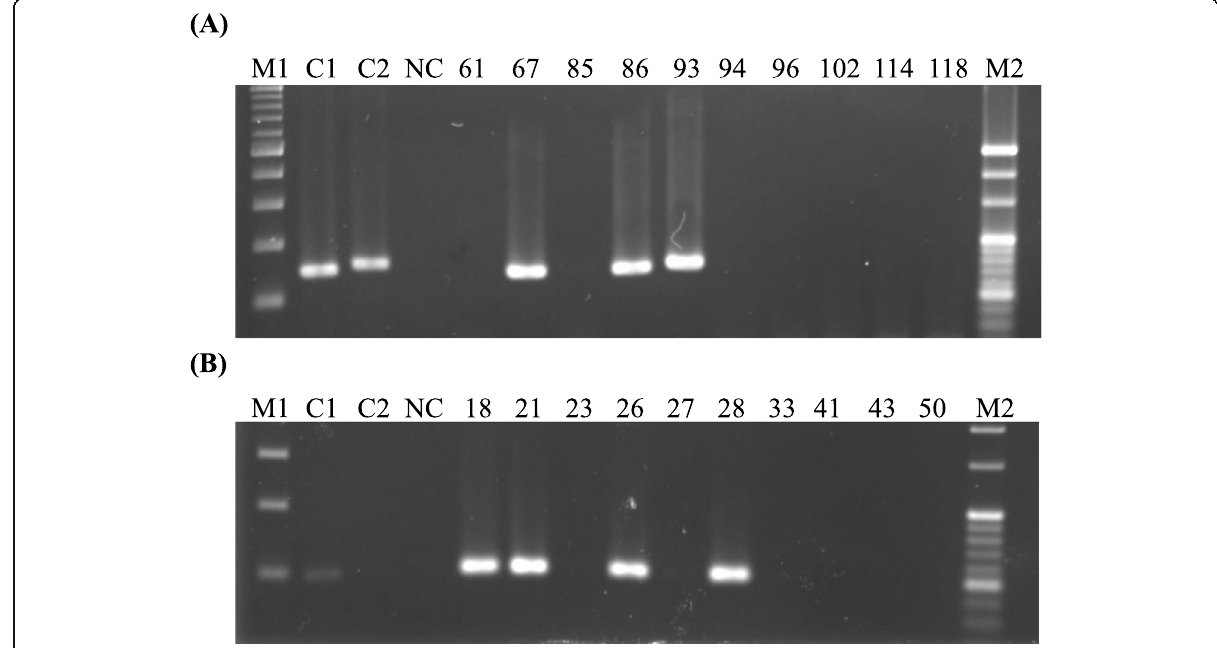
Fig. 3 An example of the electrophoresis of PCR products amplified from rice aDNA samples from the west trench at the Mojiaoshan site. a Amplicons obtained by using the specific primer targeting rps16 intron 1. b Amplicons obtained by using the specific primer targeting Orf100 F1 and R1. M1 = 100 bp DNA ladder (Takara, Japan), C1 = Oryza sativa Japonica ‘ Ta-pei-mang ’ , C2 = Oryza sativa Indica “ P.T.B.10 ” , 61 – 118 and 18 – 50 = Archaic rice grains, M2 = 20 bp DNA ladder (Takara,